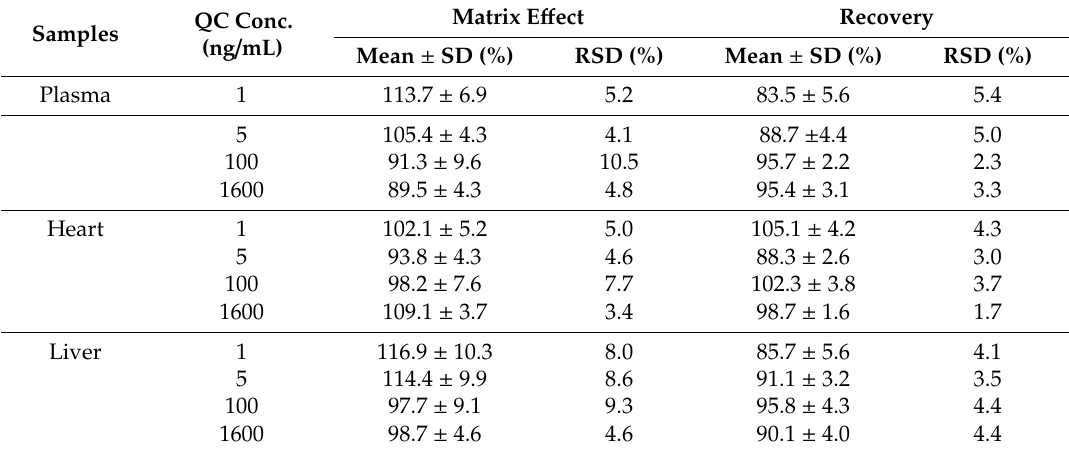
Table 3. The matrix e ff ect and recovery of alnustone in di ff erent samples ( n =